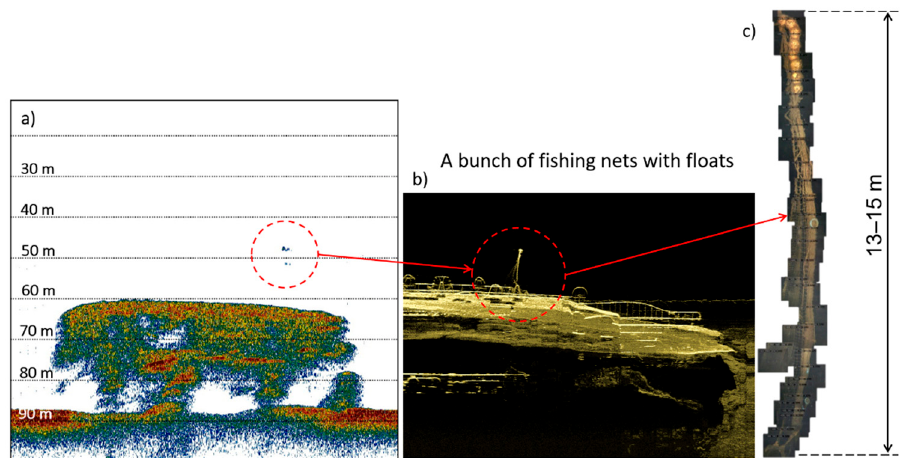
Figure 27. Acoustic echo over the wreck registered at 47 m depth ( a ); sonar echo detected with SSS ( b ) and results of remote underwater vehicles (ROV) investigation—mosaic of video shots made by Cmdr Adam Olejnik, the Polish Naval Academy ( c ).